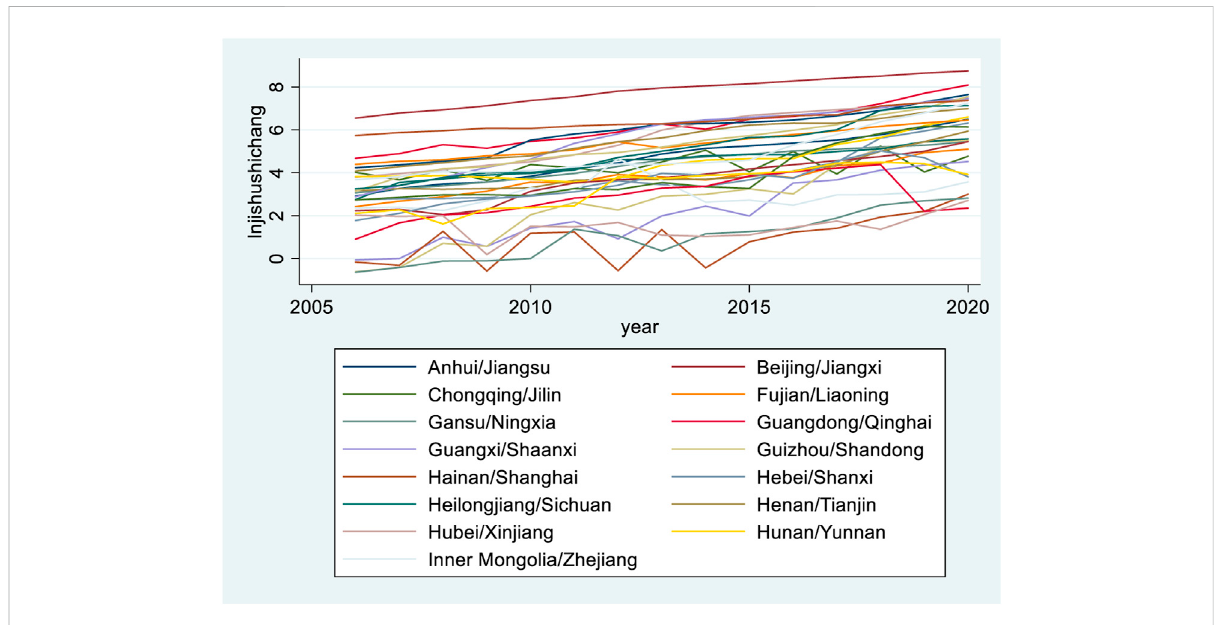
FIGURE 1 Trend of technical market